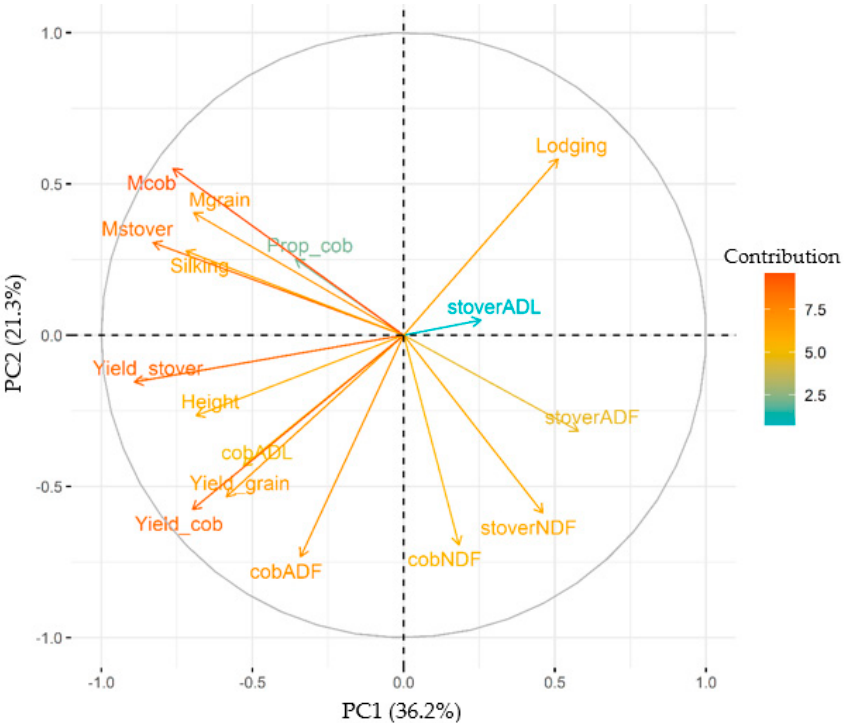
Figure 4. Plot of variable contributions of the principal components analysis (PCA) of components 1 (PC1) and 2 (PC2) across four environments in 2010 and 2011 in Pontevedra, Spain. Each arrow represents one trait: grain yield (yield_grain), cob yield (yield_cobs), and stover yield (yield_stover); NDF, ADF, and ADL (cobs and stover); agronomic traits, defined as silking, height, proportion of cob (prop_cob), and lodging; grain moisture (Mgrain), cob moisture (Mcob), and stover moisture (Mstover). The length of each arrow indicates the contribution of the trait, and the orientation shows the correlation between variables.